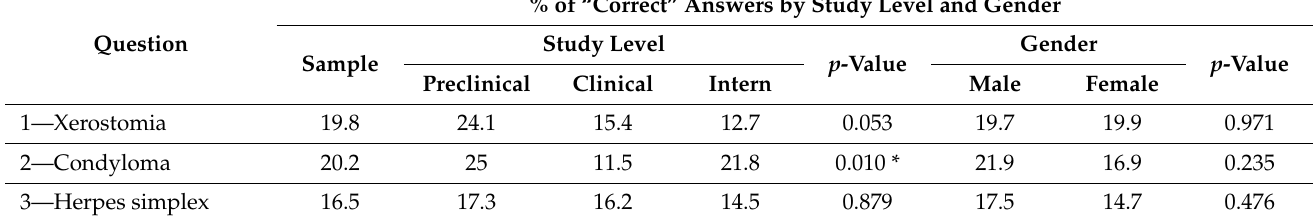
Table 4. Response of participants to knowledge-related questions regarding oral manifestation of HIV by gender and study level (no =